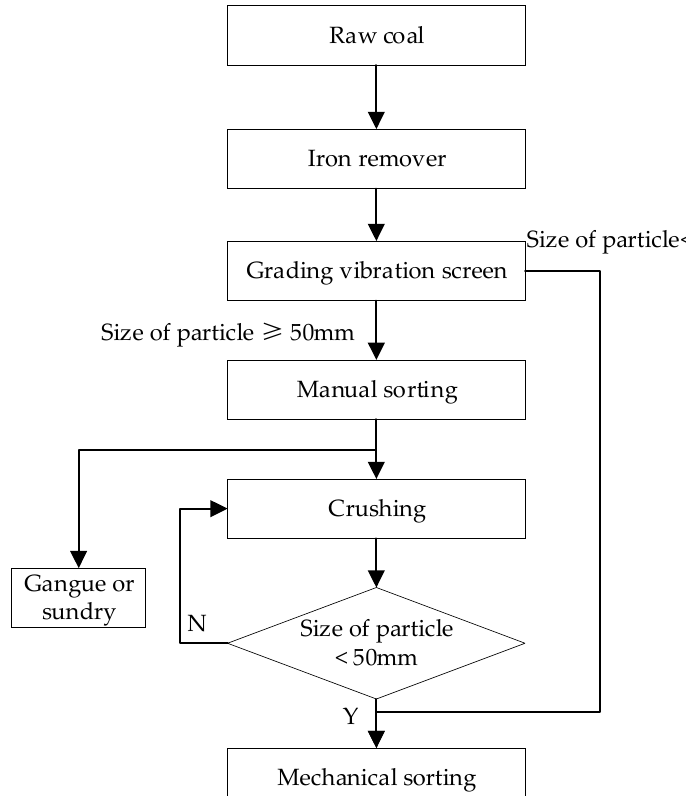
Figure 1. The block diagram of raw coal’s preparation process.